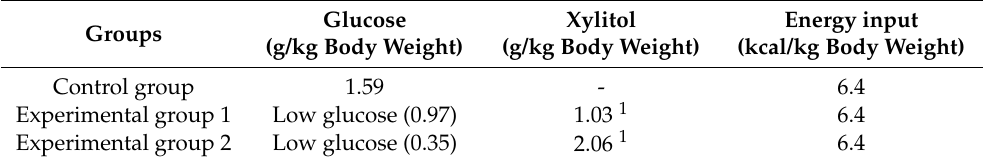
Table 1. Amount of glucose and xylitol in each experimental group. Glucose Xylitol Energy input Groups (g/kg Body Weight) (g/kg Body Weight) (kcal/kg Body Weight) Control group 1.59 Experimental group